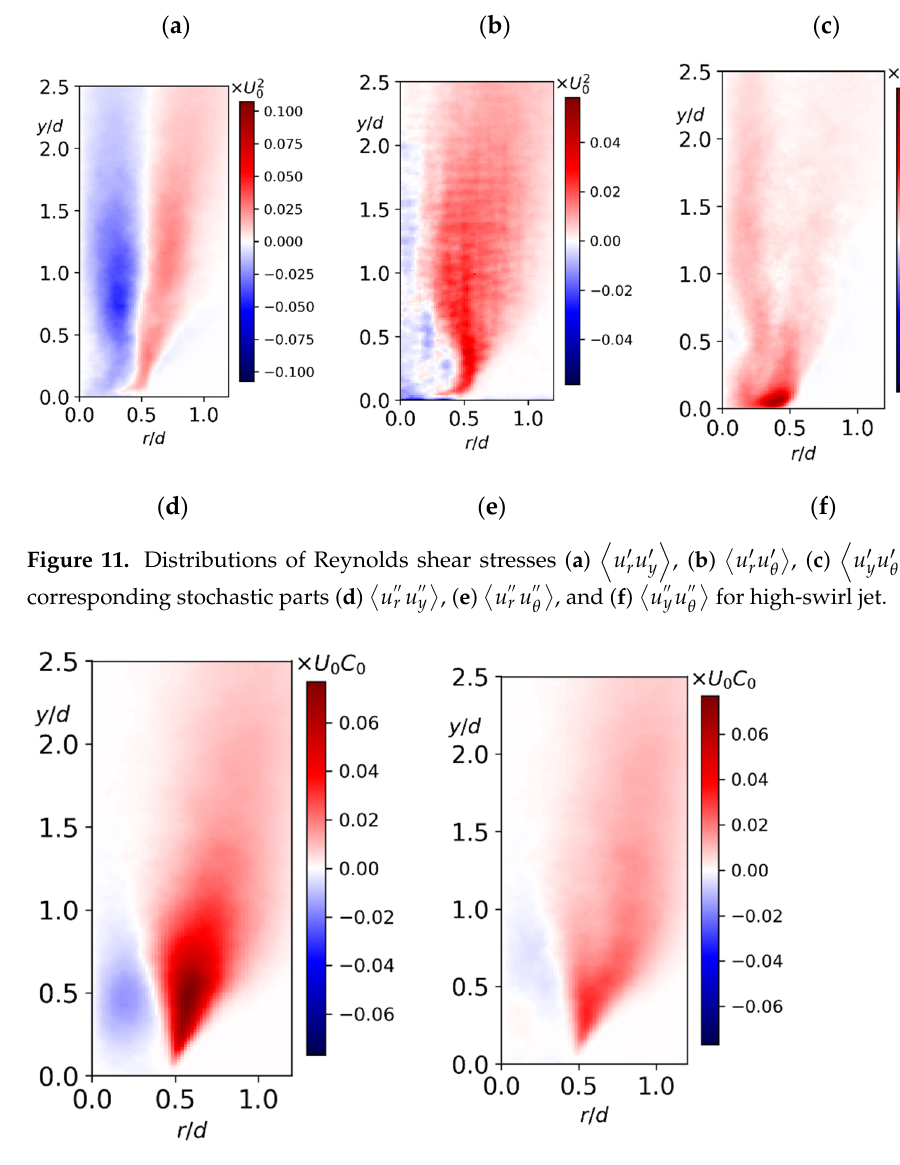
Figure 12. Radial turbulent flux for ( a ) total and ( b ) stochastic turbulent fluctuations for high-swirl